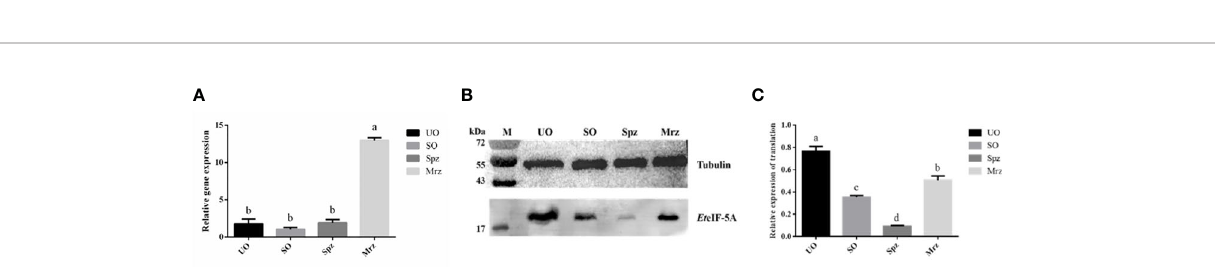
FIGURE 6 | Co-localization of Et eIF-5A and Et CDPK4 in Eimeria tenella . (A) Sporozoites before cell invasion; (B) Sporozoites at 2 h post infection; (C) Second- generation merozoites; (D) Trophozoites at 2 h post